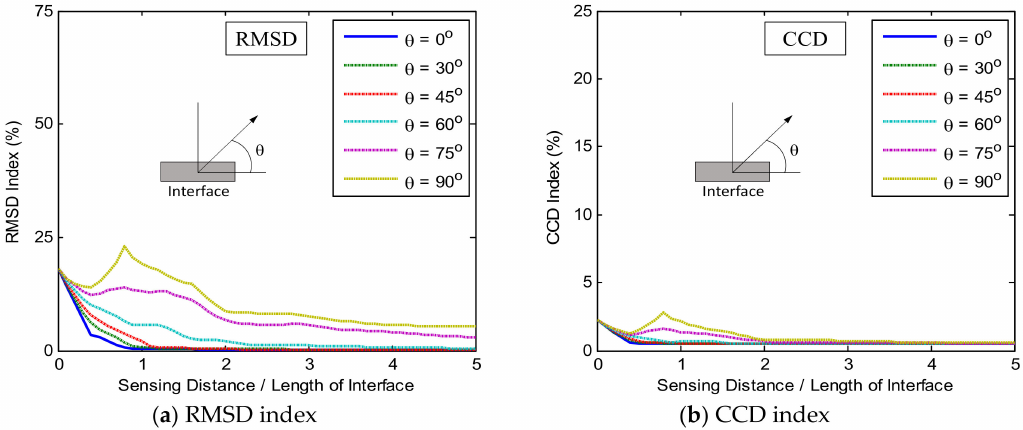
Figure 6. Relationships between damage-sensitive impedance features and sensing distance: Peak 2 in 30–40